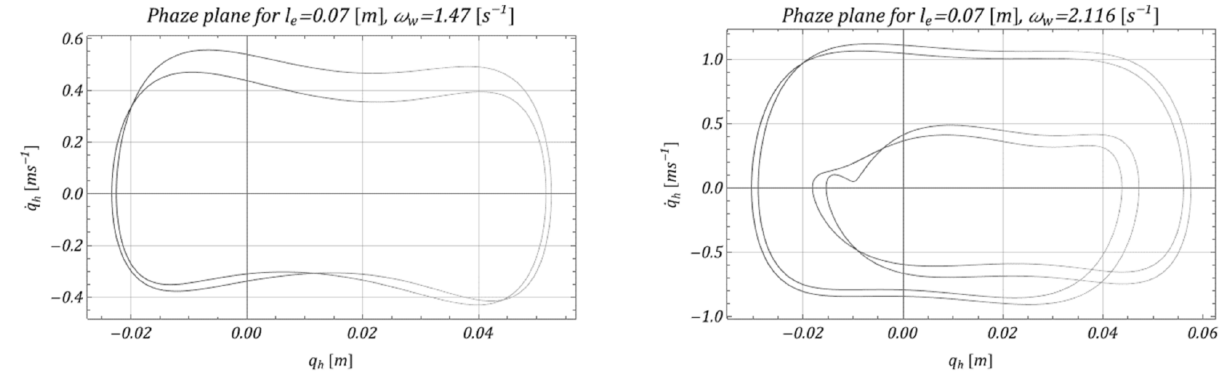
Figure 14. Voltage output and displacement time series related to selected solutions—sample chaotic solutions for l e = 0.01 m.